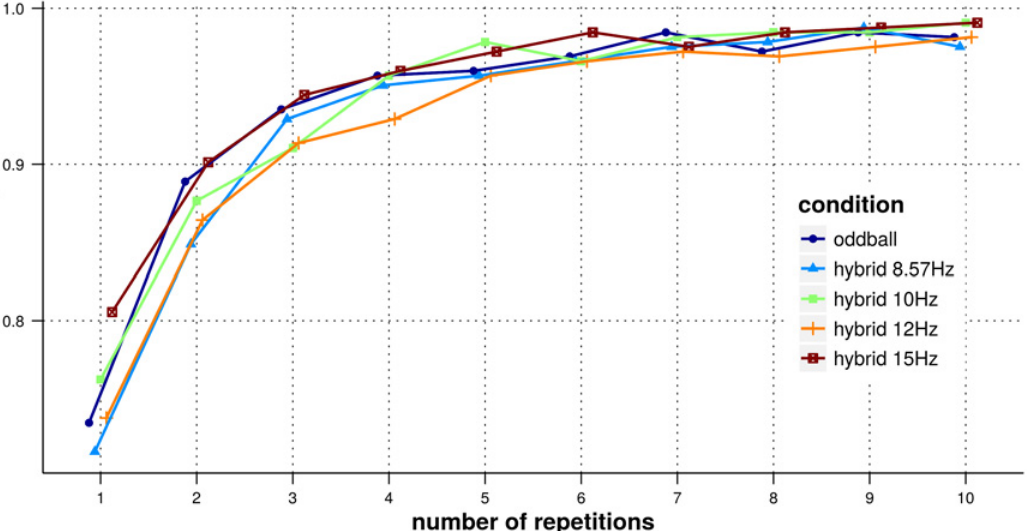
Fig 6. Accuracy of P300 ERP detection. The x-axis represents the number of repetitions, results are shown for each experimental condition and detection accuracies are averaged over subjects.